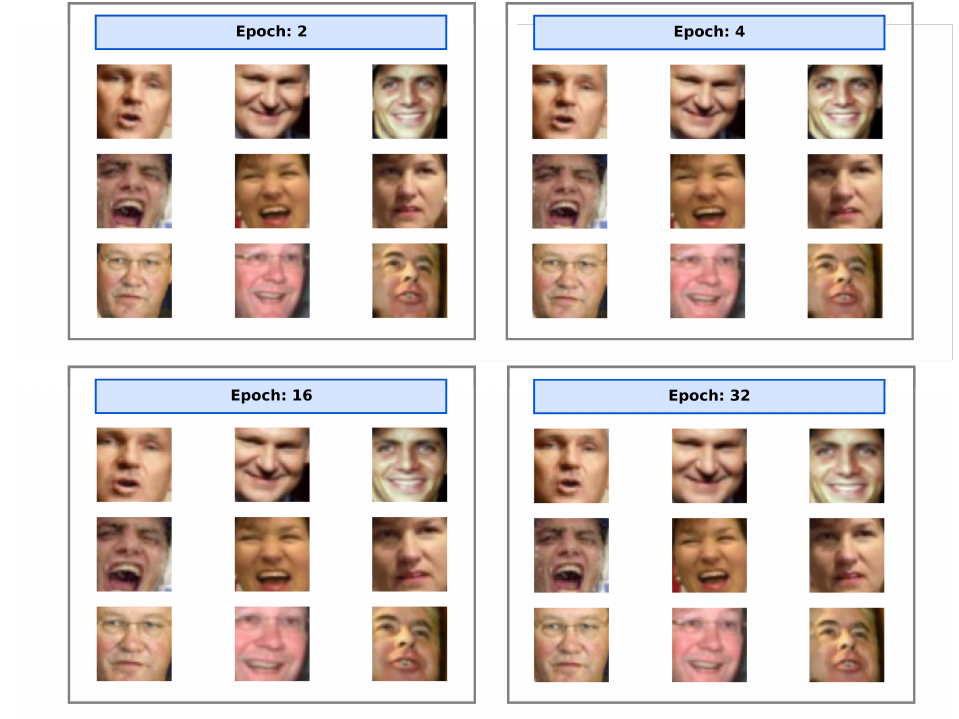
Figure 14. Differently from the previous case, this figure shows the evolution of the STN output for the training of the STN component only, providing a pre-trained ‘distilled net’ as the embedding model. In just one epoch, the STN learns to align each face putting the eyes horizontally, and emulating the crop factor of the former Dlib face